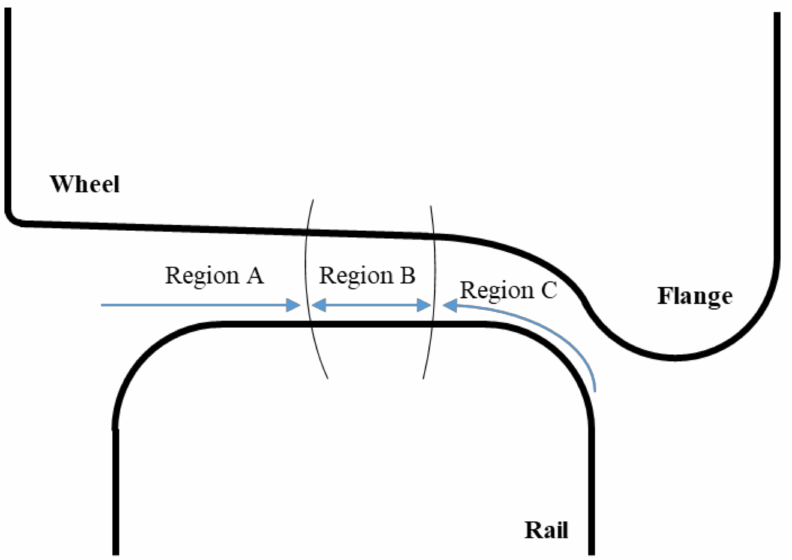
Figure 2. Wheel-rail contact geometry [40].